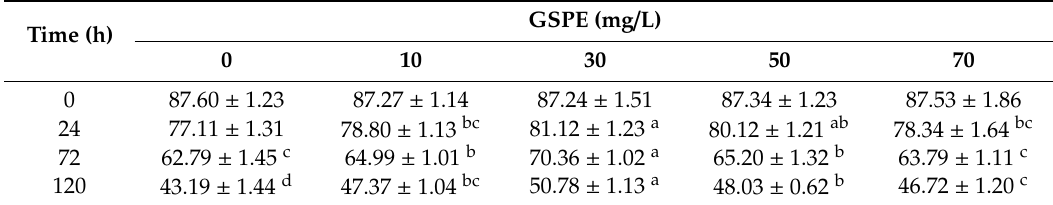
Table 4. E ff ect of grape seed procyanidin extracts (GSPE) on the mitochondrial activity of goat sperm of preserved at 4 ◦ C